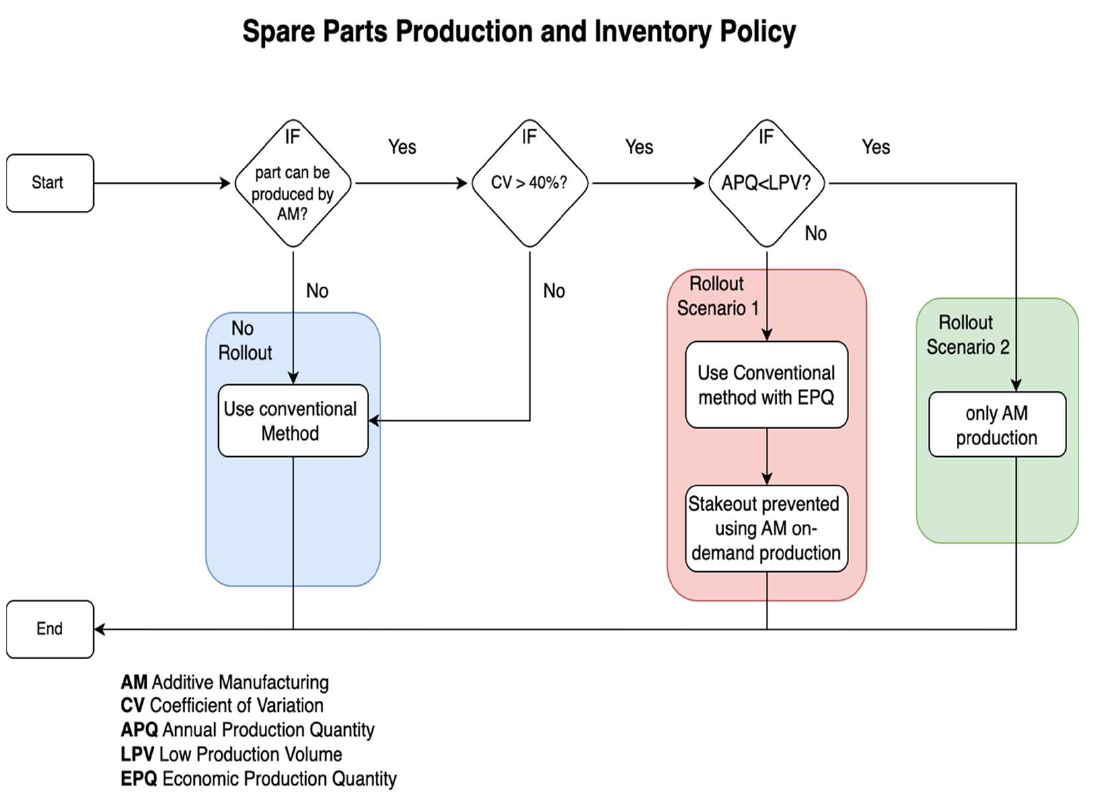
Figure 1. A framework to differentiate the distinct AM rollout scenarios in relation to demand volatility level and production volume.